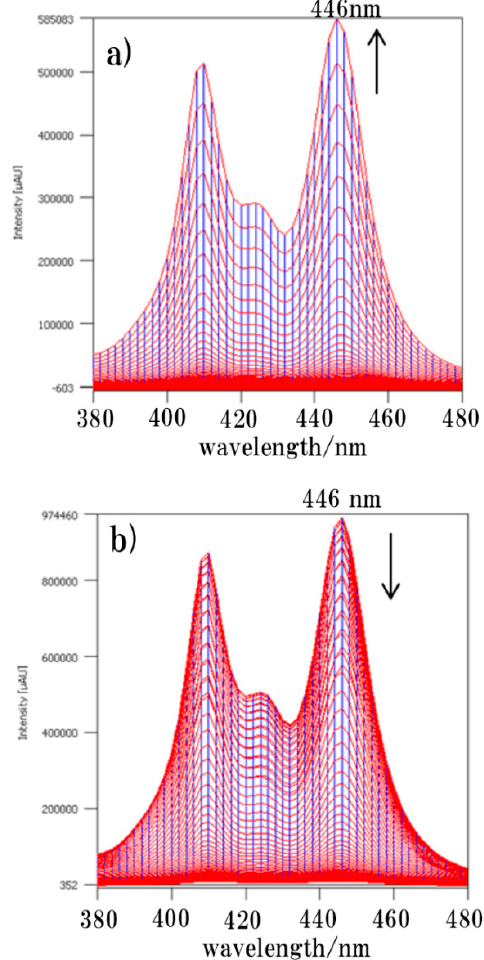
Figure 19. ( a ) UV-vis spectra of PY-GP1 and PEG8-GP1 overlaid before the peak maximum (17.8 min) in Figure 18d. ( b ) Overlaid after the peak maximum in Figure 18d. The maximum wavelength is constant at 446 nm in both ( a ) and ( b ).